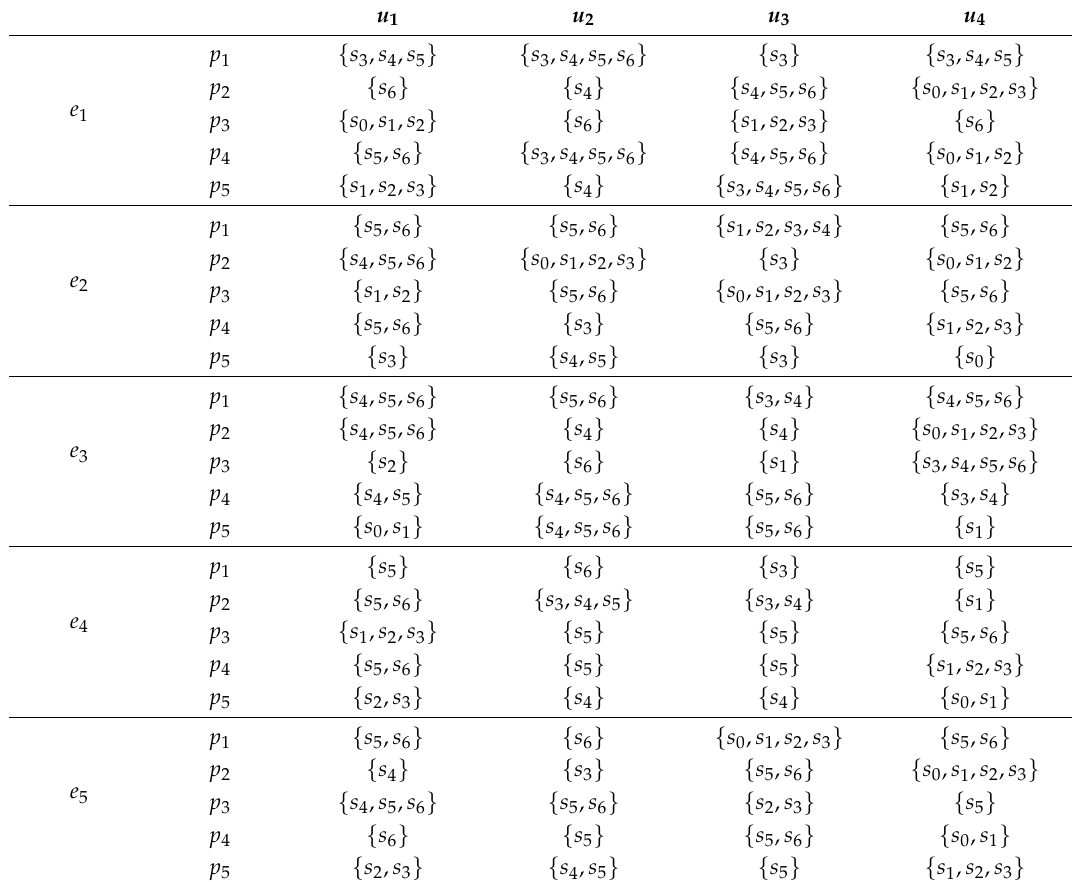
Table A1. Completed HFLTS-represented decision-making